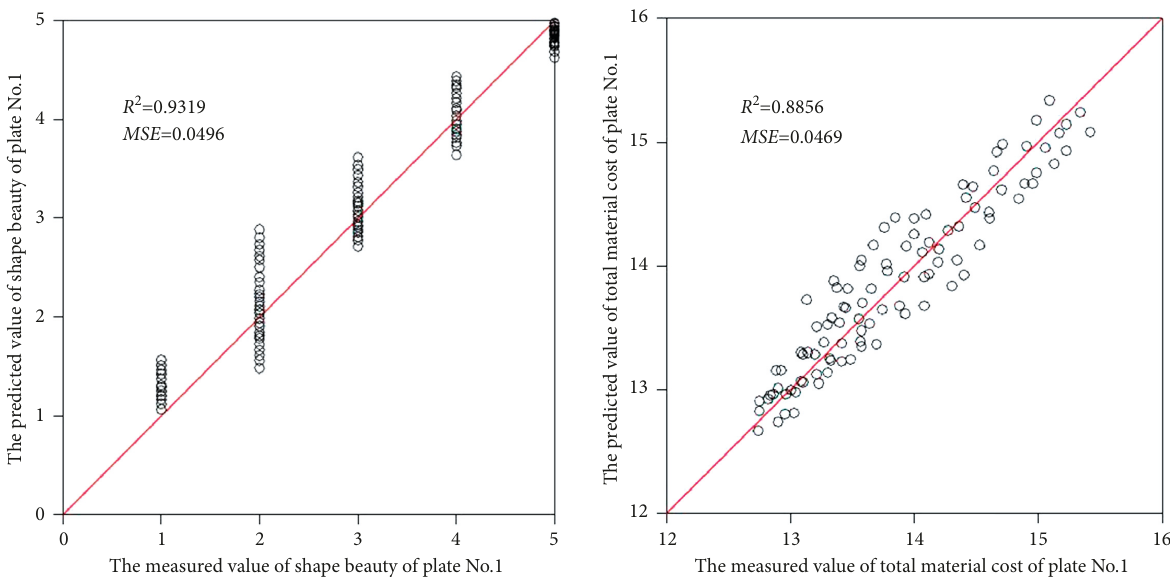
Figure 14: Fitting situation of the training samples in plate no. 1.